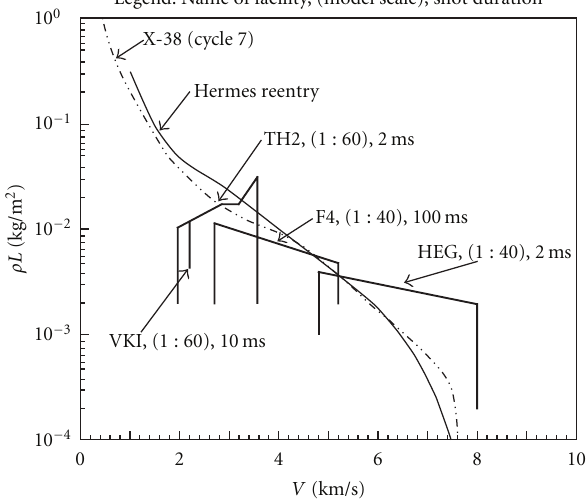
Figure 2: Performance envelopes (binary scaling parameter as function of velocity) of HEG, TH2, F4 and Longshot (VKI) for Earth suborbital reentry according to Kordulla et al.